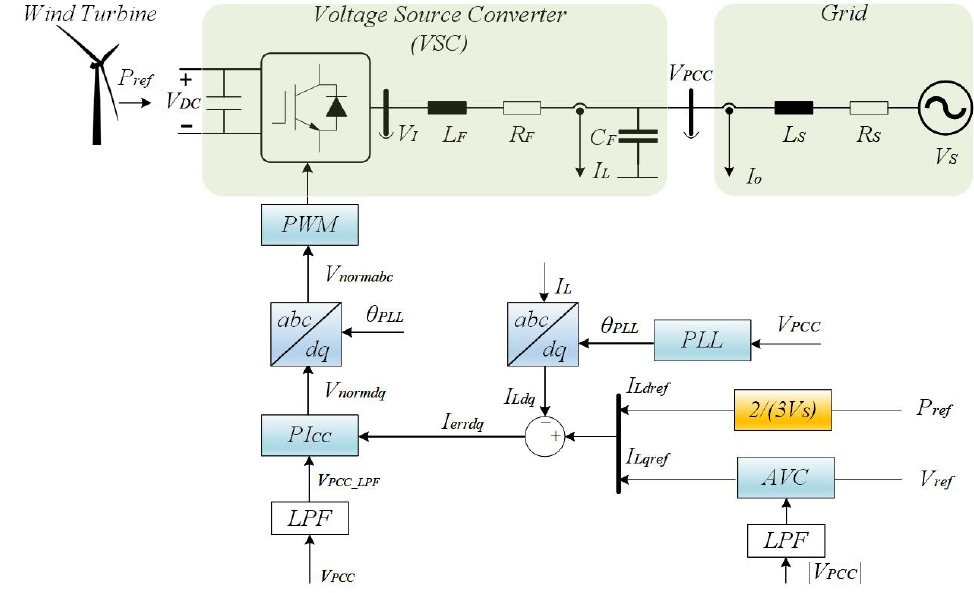
Figure 1. Grid-following VSC converter connected to the grid with its control